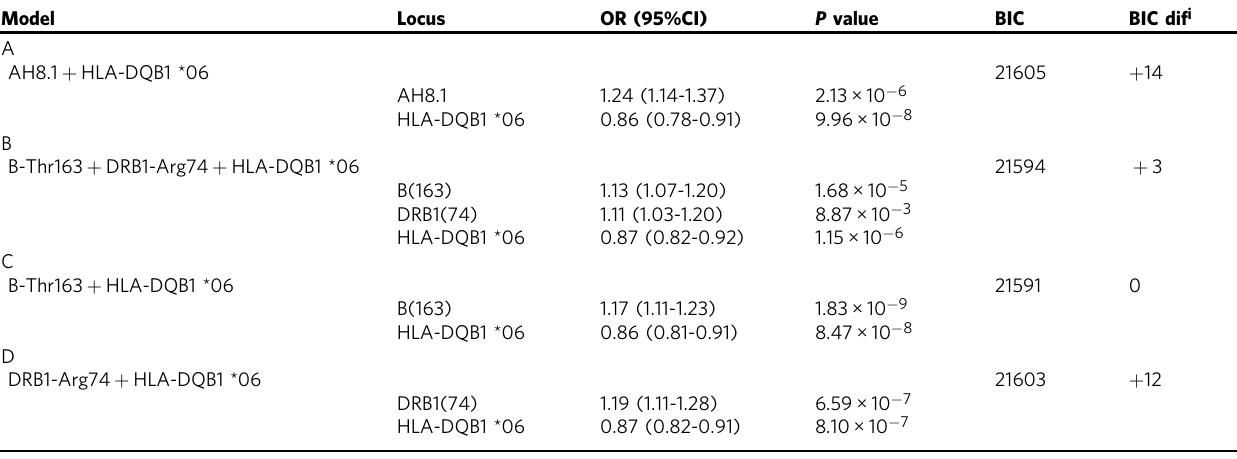
Table 4 HLA alleles and amino acids contained in the best models obtained for SCC in Europeans judged by the BIC criterion